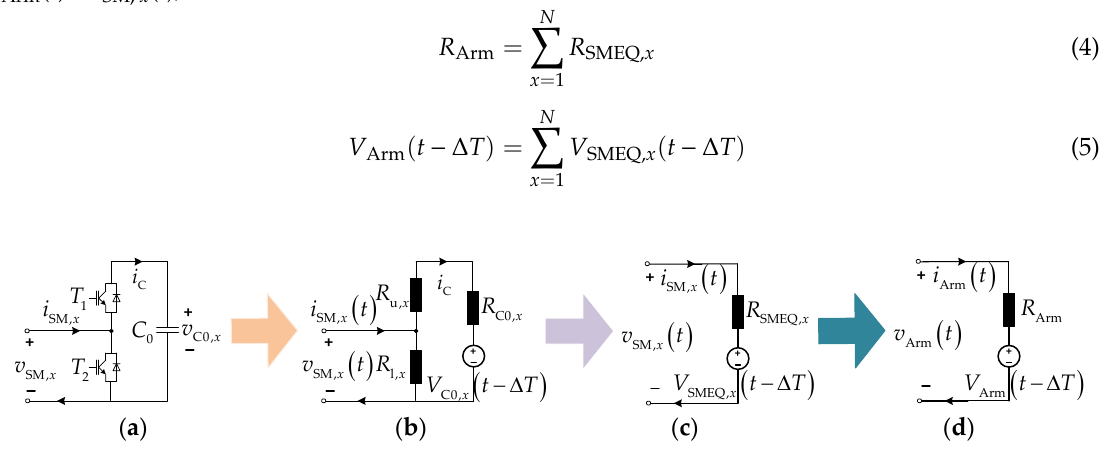
Figure 3. The detailed equivalent models (DEM) topology: ( a ) The HBSM; ( b ) The submodule (SM) equivalent circuit, with companion model; ( c ) The SM Thévenin equivalent circuit; ( d ) The arm Thévenin equivalent circuit.